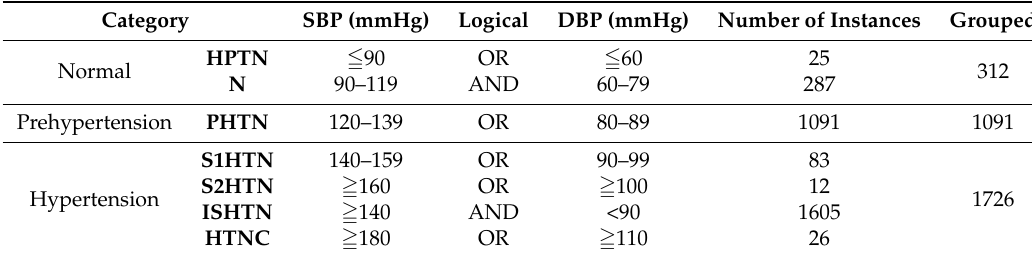
Table 2. Rules and